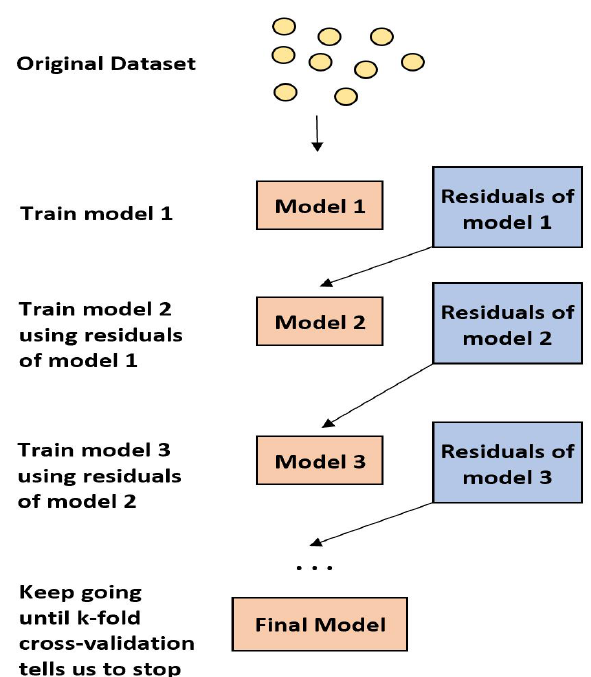
Figure 7. Flow Chart of Gradient boosting